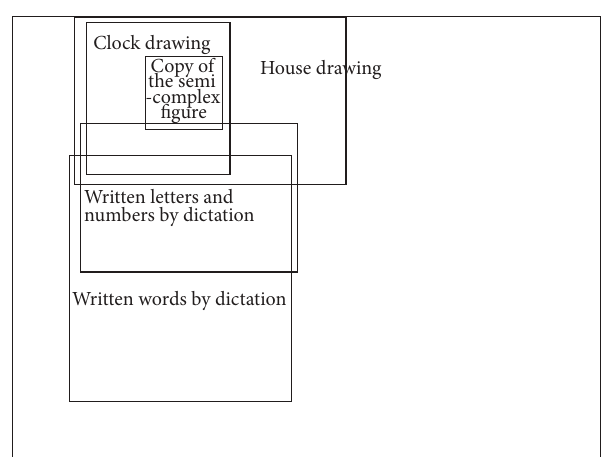
Figure 5: Location of examples on the sheet of